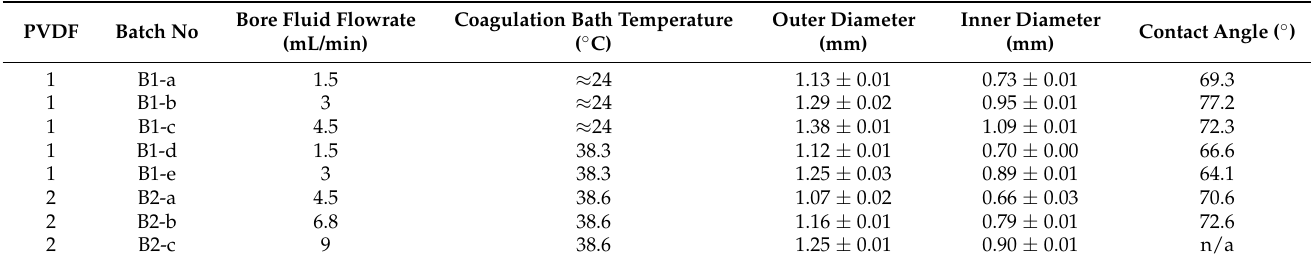
Table 3. Hollow fiber casting conditions for small 1.5 kg batches using PVDF 1 and PVDF